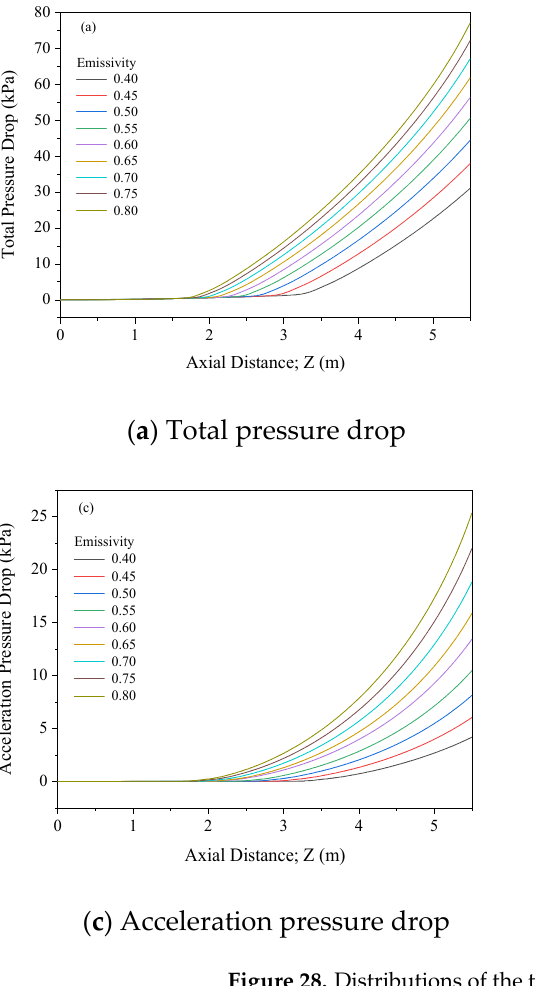
Figure 28. Distributions of the total pressure drop and its components along the axial direction under wall emissivity of 0.40 to 0.80.